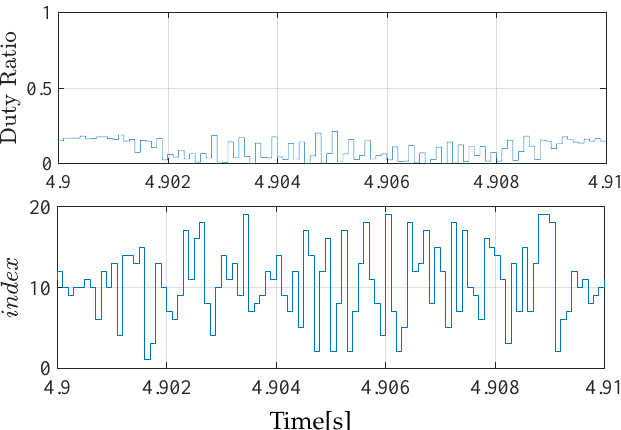
Figure 12. The duty ratio for Pulse Width Modulators (PWM) and the index of the sub-module to be modulated.